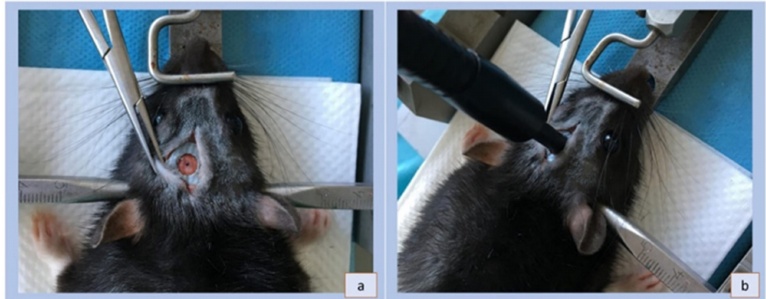
Figure 1. The photographs show the non-transparent mask used to protect the skull from light overexposure. The mask was made of a flexible 120 mesh artificial silk fabric covered with a layer of moisture and damage-resistant polyethylene. The fabric was totally opaque to block the light; ( a ) the mask fitted closely to the skull, revealing only an area intended for exposure; ( b ) the matching of the optical fiber with the mask before